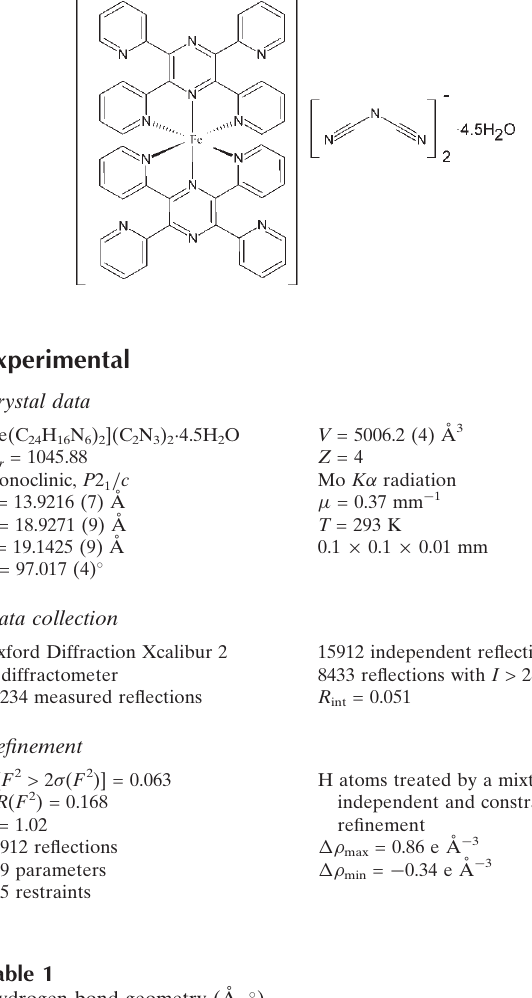
Hydrogen-bond geometry (A˚ , (cid:4) ). D —H (cid:2)(cid:2)(cid:2) A D —H H (cid:2)(cid:2)(cid:2) A